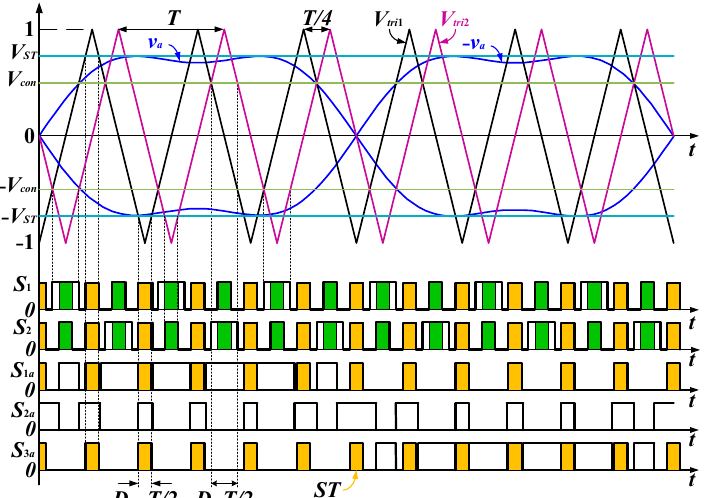
Figure 2. The proposed PWM scheme.